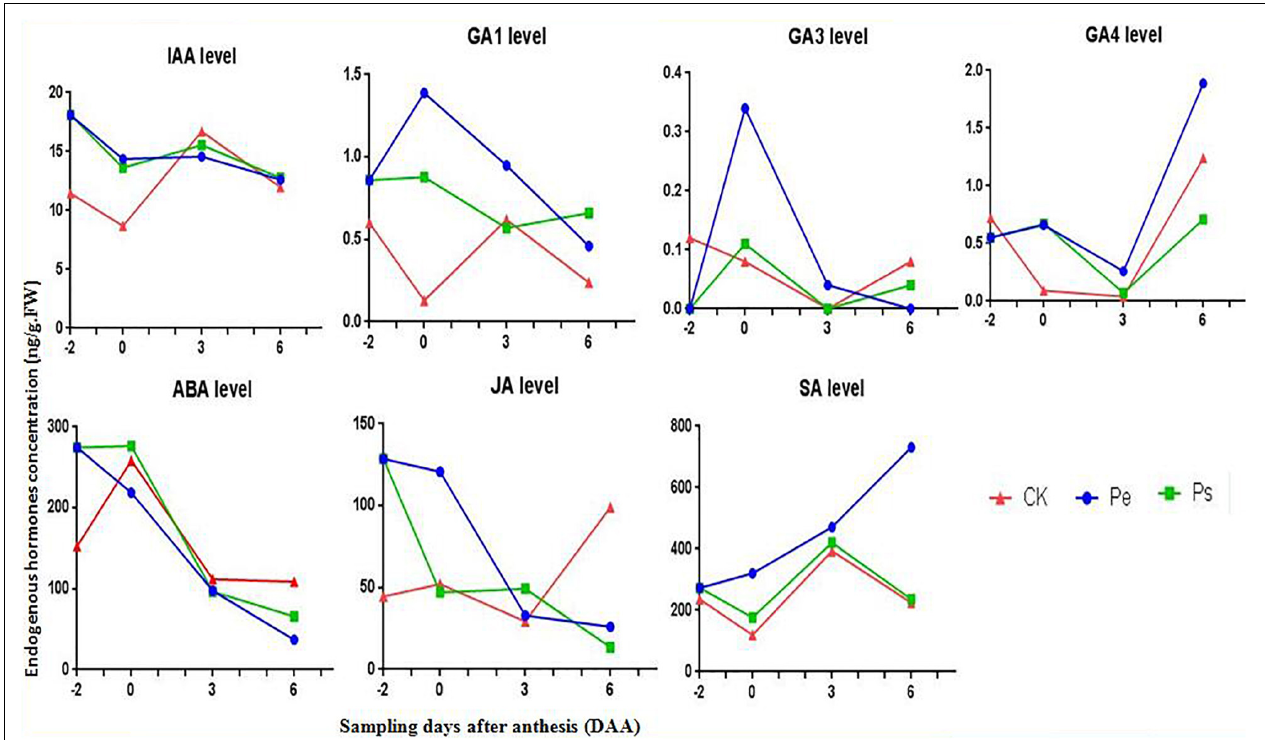
FIGURE 3 | Comparison of the phytohormone levels (IAA, ABA, GA 1 , 3 , 4 , SA, and JA) between Pe (stigma removed in “R35-P”), Ps (self-pollination in “R35-P”), and CK (self-pollination in “R35-N”) at − 2, 0, 3, 6 days after anthesis